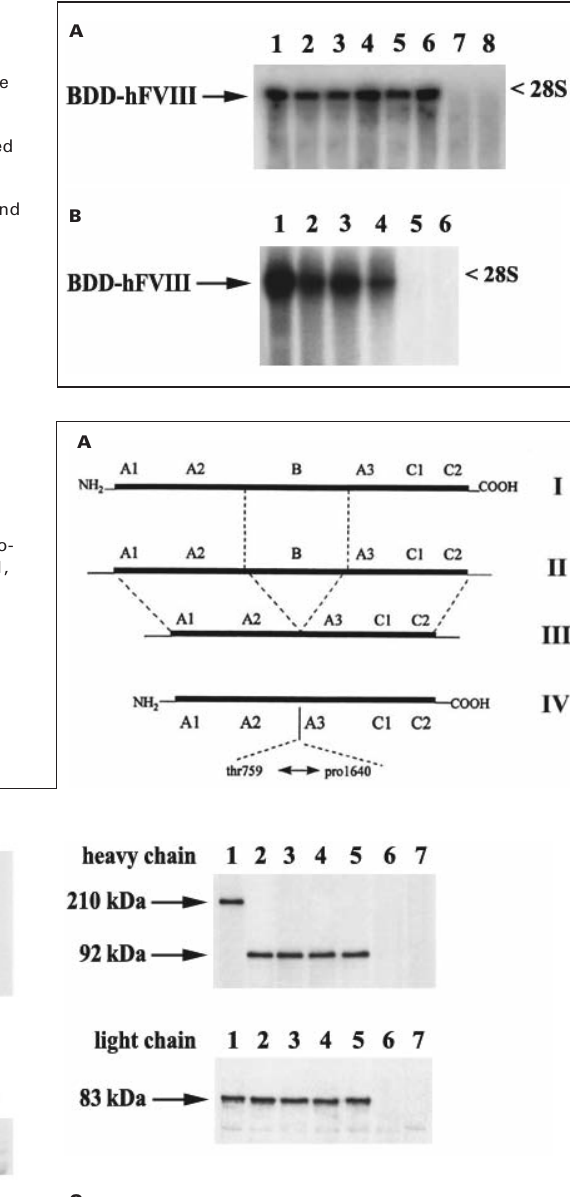
Figure 3 Western blotting of human FVIII expressed in tissues of transgenic mice. A Two forms of cDNA and protein for human FVIII. I: full-length FVIII protein, which was composed of A1, A2, B, A3, C1 and C2 domain; II: full-length FVIII cDNA, which was composed of A1, A2, B, A3, C1 and C2 domain; III: B domain deleted FVIII cDNA, which was composed of A1, A2, A3, C1 and C2 domain; IV: B domain deleted FVIII pro- tein (760~1639 amino acids were deleted, hFVIII Δ 760~1639aa ), which was composed of A1, A2, A3, C1 and C2 domain. B Western blotting from transgenic F0 progeny: recombinant full-length human FVIII containing B-domain (lane1), the heavy chain of which was approximately 210 kDa, and the light chain was 83 kDa; a 92 kDa heavy chain and a 83 kDa light chain were presented in sample 3 F0 progeny (lane 2 and 3), sample 6 F0 progeny (lane 4 and 5) and sample 8 F0 progeny (lane 6 and 7), while no band was visible in sample 1 non- transgenic F0 progeny (lane 8 and 9). Lane 2, 4, 6 and 8 were from liver samples; lane 3, 5, 7 and 9 were from the kidneys. C Western blotting from transgenic F1 progeny: recombinant full-length human FVIII containing B-domain (lane1) presented a 210 kDa heavy chain and a 83 kDa light chain, sample 6-2 F1 progeny (lane 2 and 3) and sample 6-5 F1 progeny (lane 4 and 5) presented a 92 kDa heavy chain and a 83 kDa light chain, while there was no band in sample 6-6 non-trans- genic F1 progeny (lane 6 and 7). Lane 2, 4 and 6 were from liver sam- ples; lane 3, 5 and 7 were from the kidneys.